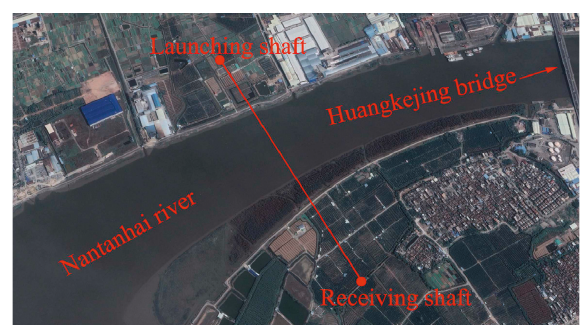
Figure 1: Diagram of traffic location and around the crossing zone.